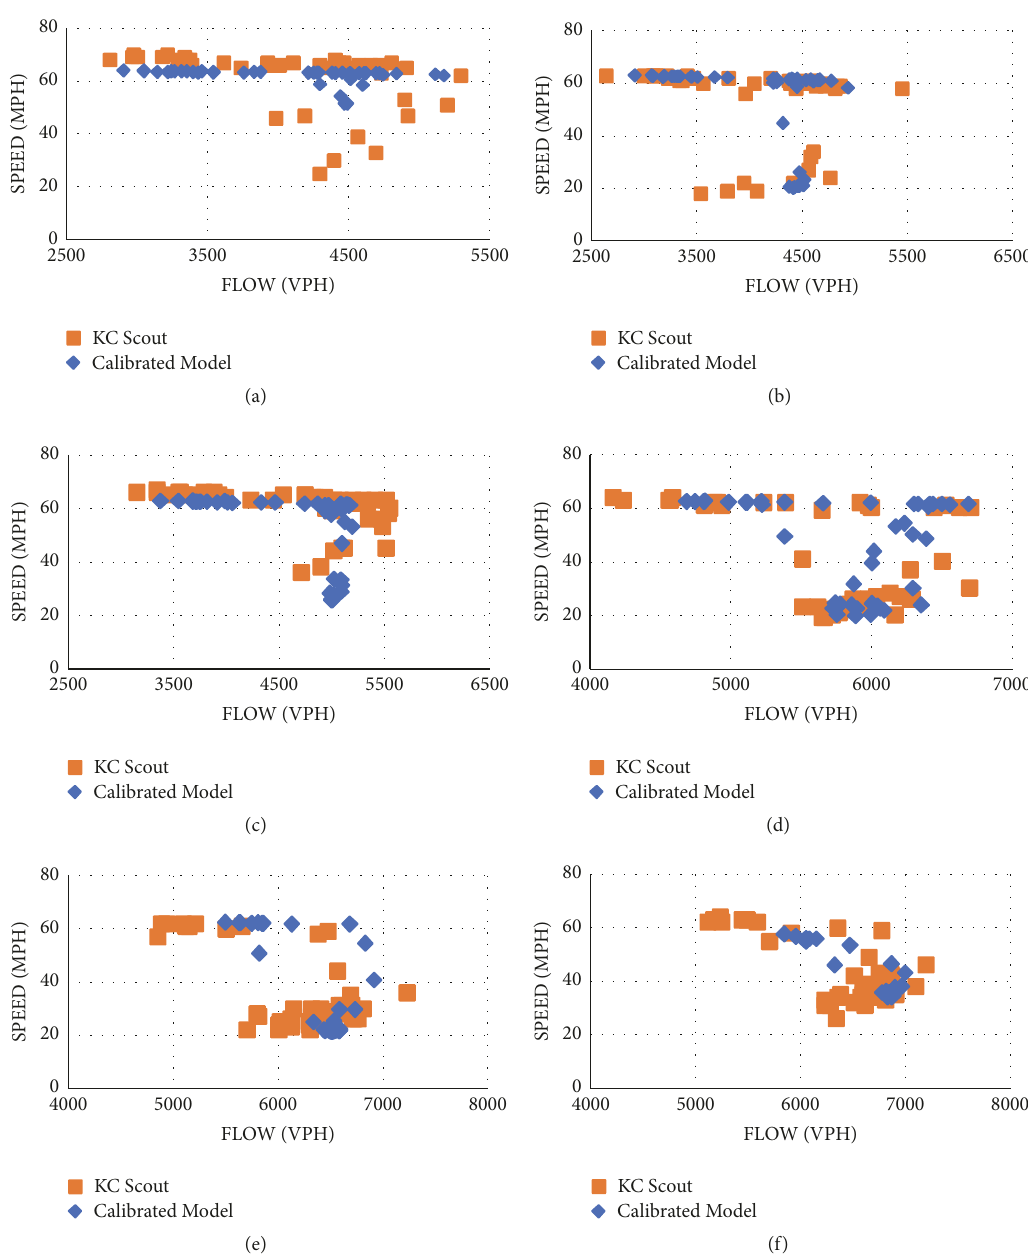
Figure 3: Speed-flow diagrams at (a) 7th St. (b) Southwest Blvd. (c) 18 th St. (d) Johnson Dr. (e) 67 th St. and (f) 67 th St. merge